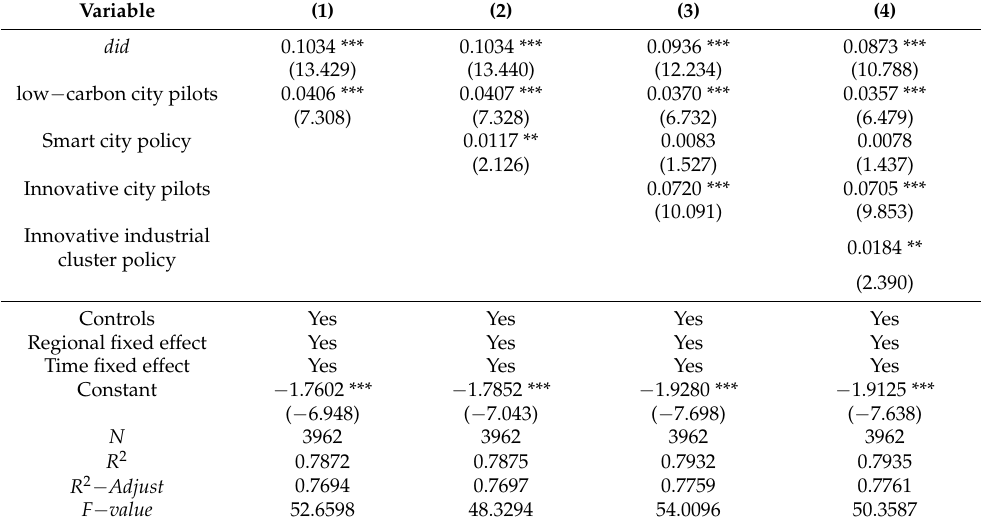
Table 5. Exclude other policy pilots.